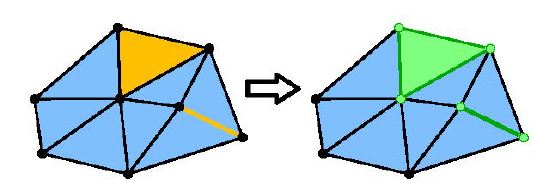
Figure 36: Two simplices ( yellow ) and their closure ( green ).